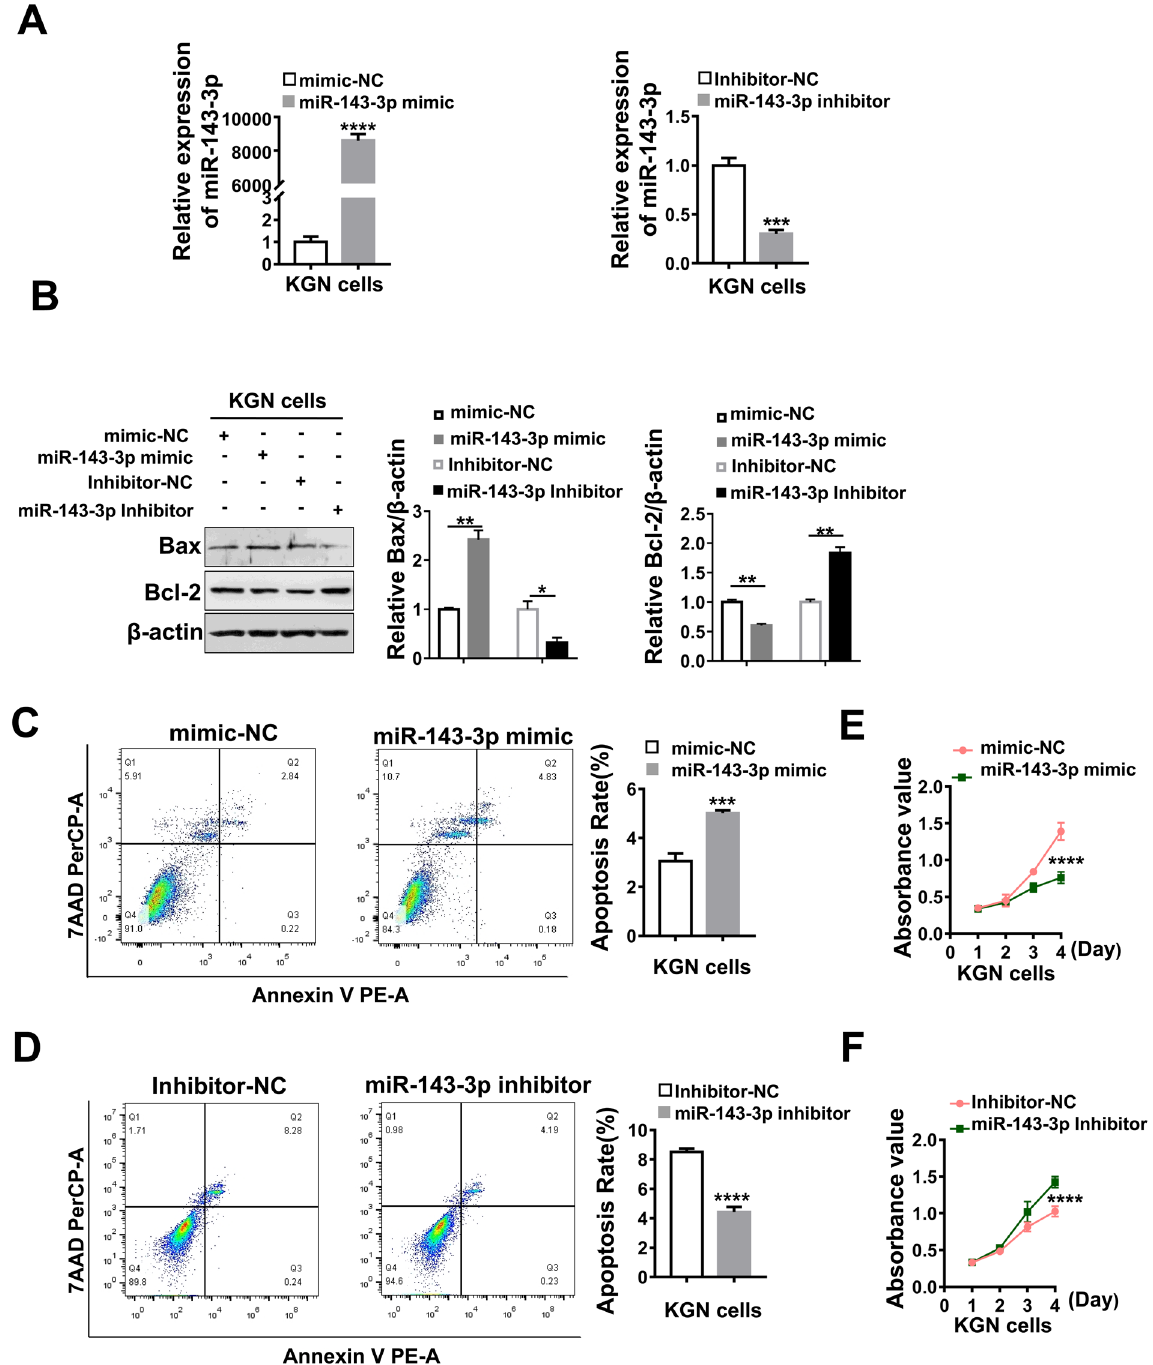
Figure 4. Exosomal-miR-143-3p promotes apoptosis and inhibits growth in KGN cells. (A) Quantitative PCR analysis of the expression levels of miR-143-3p in KGN cells transfected with miR-143-3p mimic or miR-143-3p inhibitor for 24 h. (B) Western blotting analysis of the expression levels of apoptosis-related proteins in KGN cells treated with miR-143-3p mimic or miR-143-3p inhibitor for 48 h. The protein expressions were quantified by using gray scale analysis. Original blots/gels are presented in Supplementary Fig. S5. (C,D) Flow cytometry detection of apoptosis after KGN cells were incubated with miR-143-3p mimic or inhibitor for 48 h. (E,F) CCK8 analysis of cell viability after primary granulosa cells and KGN cell incubation with miR-143-3p mimic or inhibitor for three days. All data are presented as the mean ± SD. Student’s t-test was used for statistical analysis. ns no significance, * P < 0.05, ** P < 0.01, *** P < 0.001, **** P <